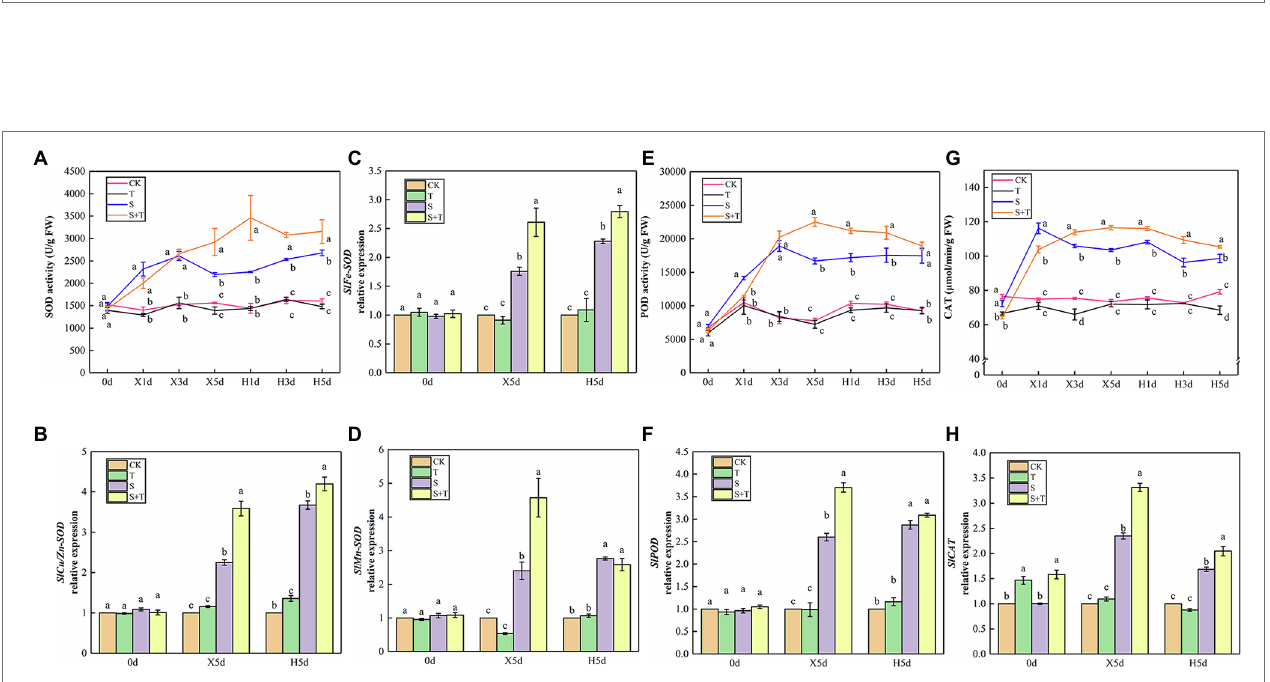
FIGURE 8 | Effects of foliar-applied trehalose on ROS accumulation of tomato leaves under stress and non-stress conditions. (A) Diaminobenzidine (DAB) staining. (B) H 2 O 2 content. (C) O 2 − content. (D) Nitroblue tetrazolium (NBT) staining. The results showed the mean ± SE of three replicates, and the different letters denote the significant difference among treatments ( p < 0.05), according to Duncan’s multiple test. CK, control; T, 10 mM trehalose; S, 150 mM NaCl; S + T, 150 mM NaCl +10 mM trehalose.